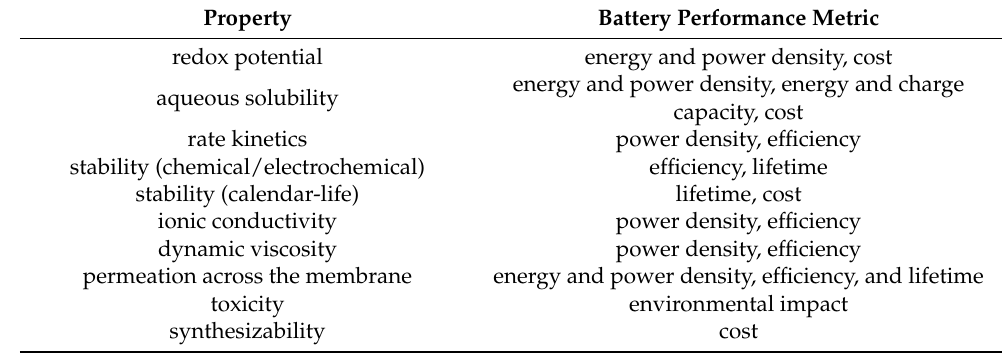
Table 1. List of key physicochemical properties of redox active materials and the aqueous redox flow battery performance metrics that depend on them. Information obtained from Fisher et al. [8], Ding et al. [12], and Cao et al. [13].